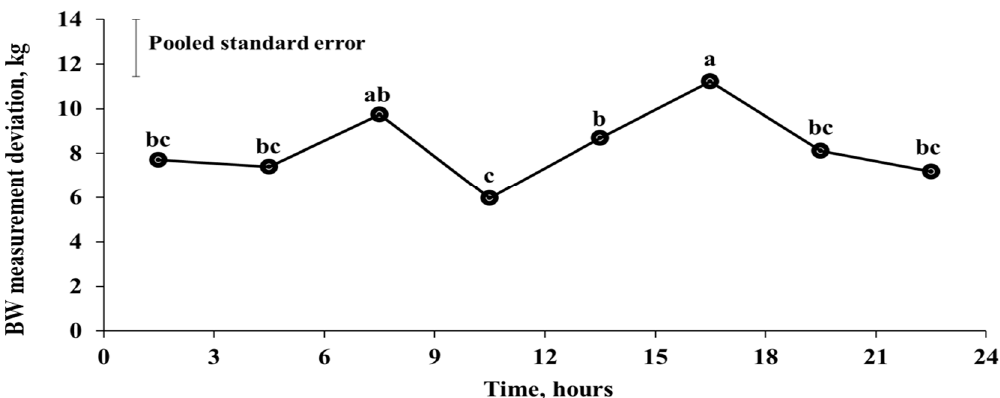
Figure 1. Daily variation BW measurement deviation with three-hour intervals. BW measurement deviation refers to the difference in BW between automated BW records and manual BW measurement. Means that do not have common superscripts (a–c) significantly differ ( p < 0.05).